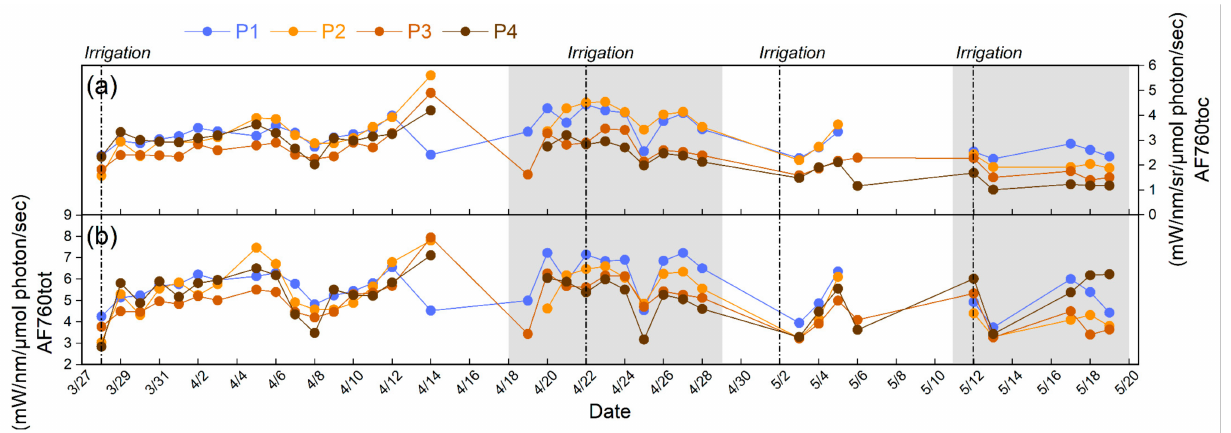
Figure 5. Seasonal patterns of ( a ) AF760toc and ( b ) AF760tot. The color and style of the dot lines and rectangles are the same as Figure 4, and the black dash-dotted lines in panels (a–c) indicate the irrigation for four